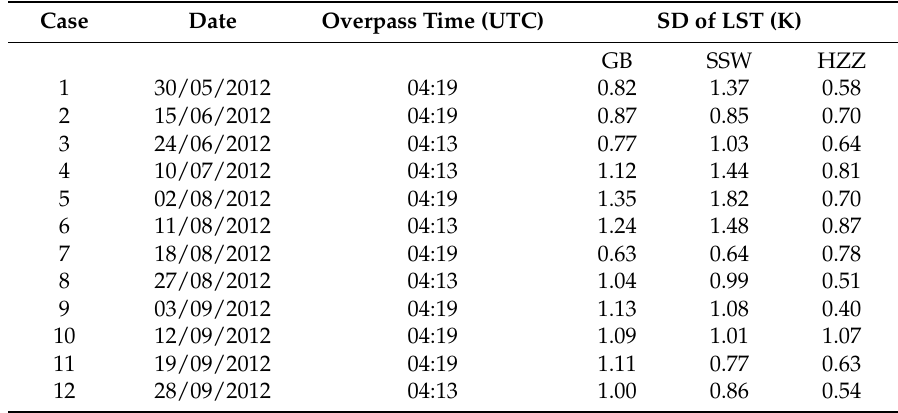
Table 2. Dates and overpass times of ASTER images and standard deviation (SD) of 11 × 11 ASTER land surface temperature (LST) pixels at three